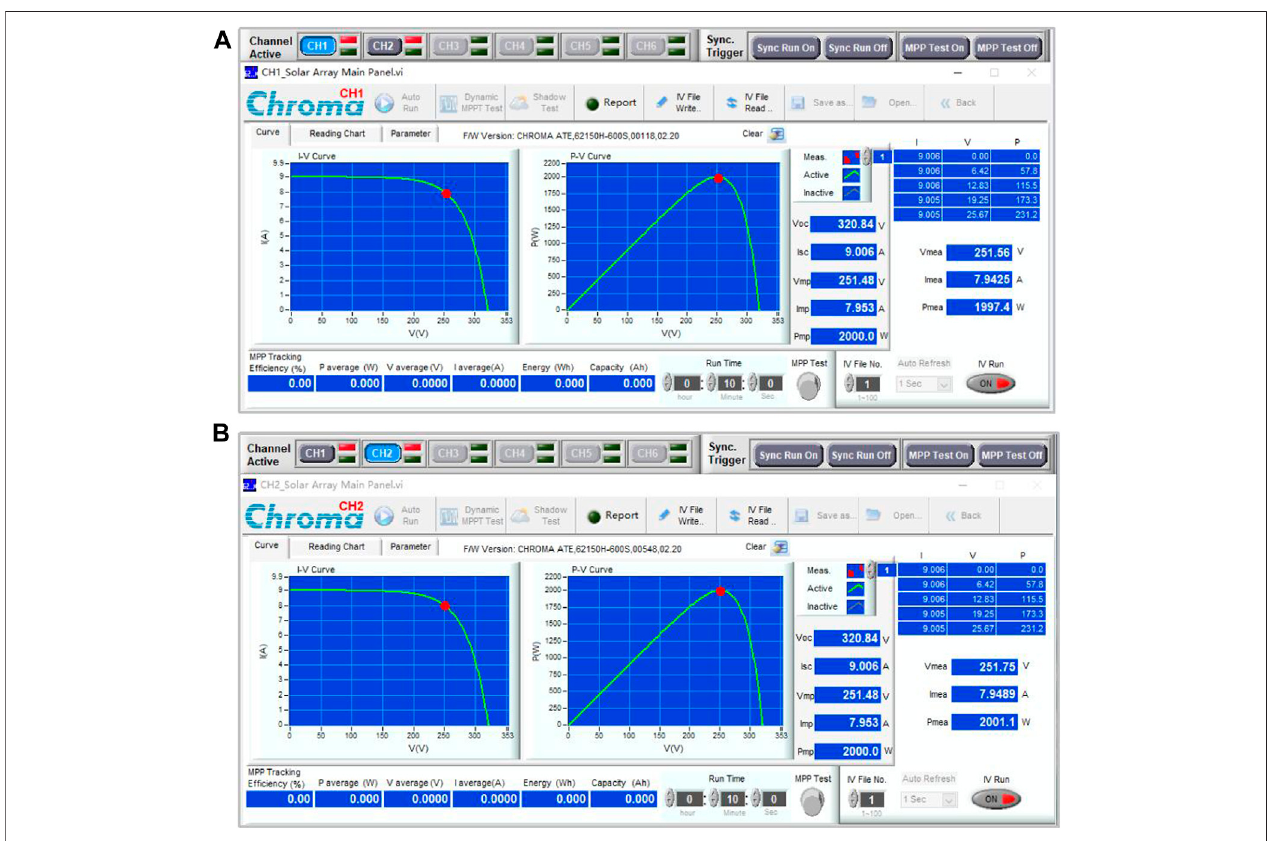
FIGURE14| SimulatingtheindependentinputmodeexperimentalconditionII: (A) InputworkingparametersofPVstring1and (B) InputworkingparametersofPVstring2.